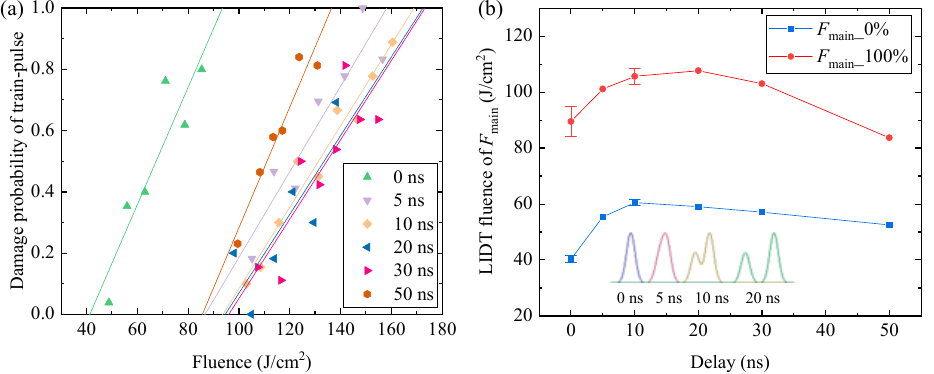
Figure 10. ( a ) Relations between damage probability and laser fluence of pulse train with various pulse delays for the shape factor η = 0.61. ( b ) Dependences of main-pulse threshold F main (0% and 100% probability) on pulse delay. The inset is the sketches for the dual-pulse shapes at the delays of 0 ns, 5 ns, 10 ns and 20